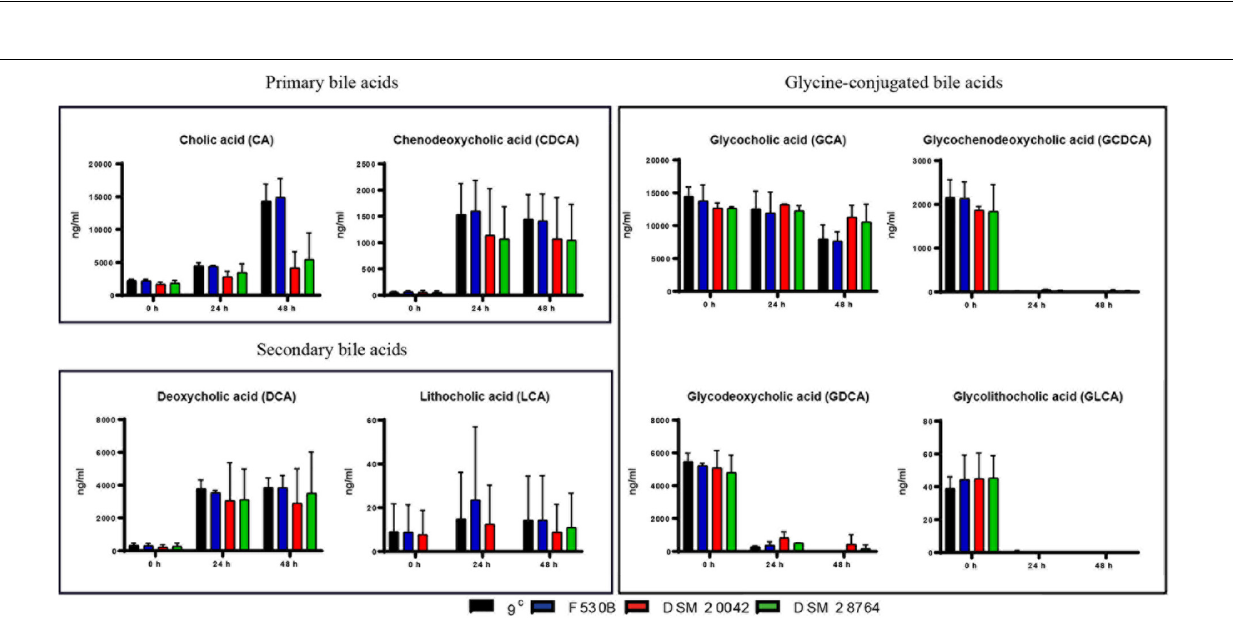
FIGURE 4 | Primary, secondary and glycine-conjugated bile acids in the media after fermentations of S. epidermidis gut isolates 9 c and F530B and skin isolates DSM 20042 and DSM 28764. Results (ng/ml) are the mean of duplicate measurements +/ − standard deviation. Media control values remain unaltered through time and are not